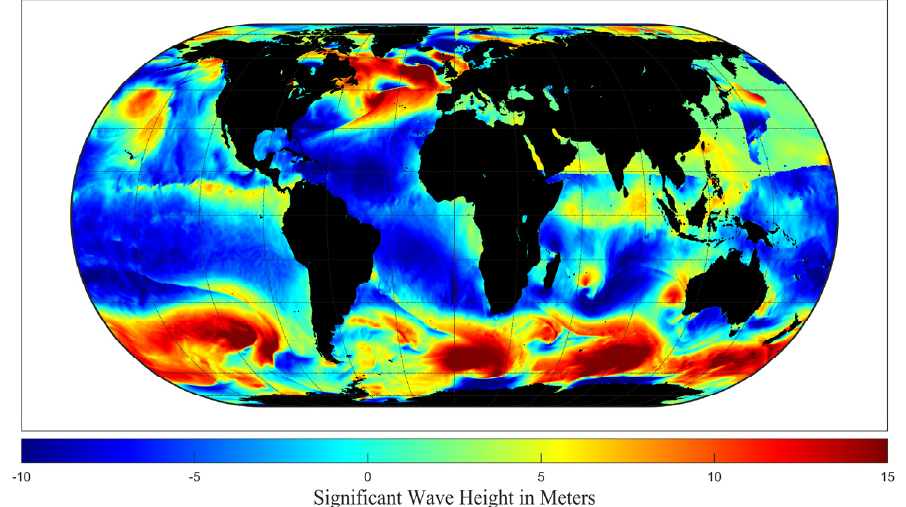
Figure 6. Significant wave height interpolated to computational grid worldwide.